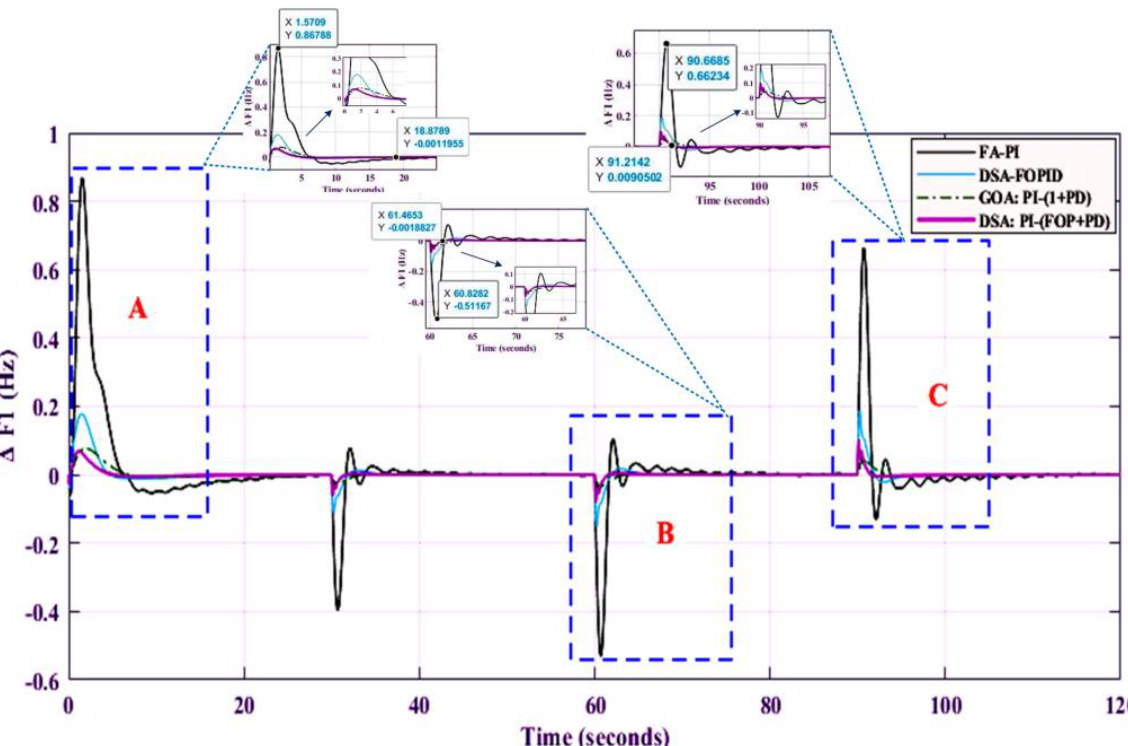
Figure 14. Area-2 frequency response.